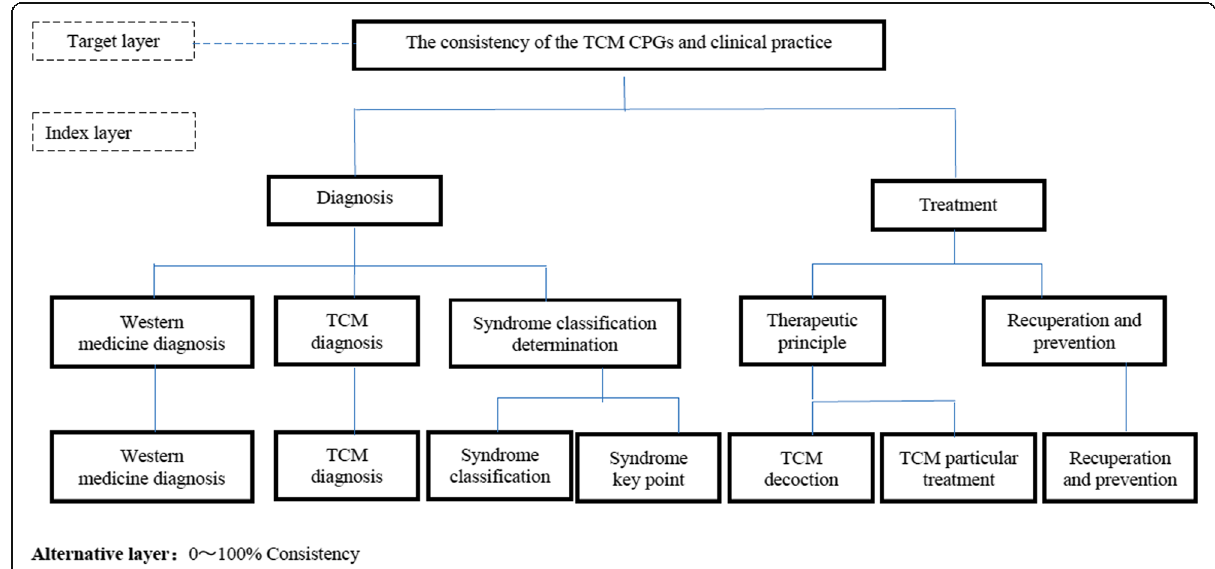
Fig. 1 Construction and weighting of the